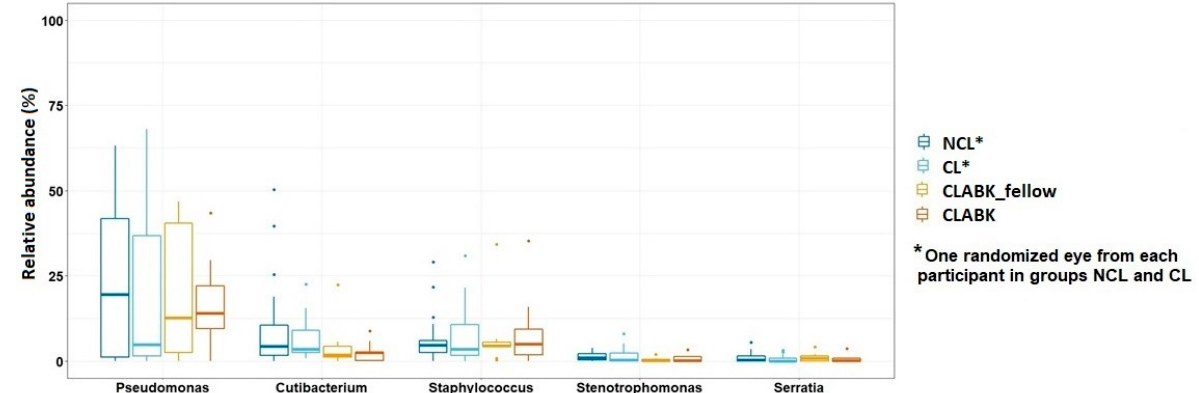
Figure 4. The relative abundance of five known bacterial pathogens to bacterial keratitis. No significant difference of the relative abundance of these five genera was demonstrated for the comparison between non-contact-lens users (NCL) vs. contact lens users (CL)/fellow eye of patient with contact-lens-associated bacterial keratitis (CLABK_fellow) or for the comparison between NCL/CL vs. eyes with bacterial keratitis (CLABK) (Kruskal–Wallis test, p > 0.05).